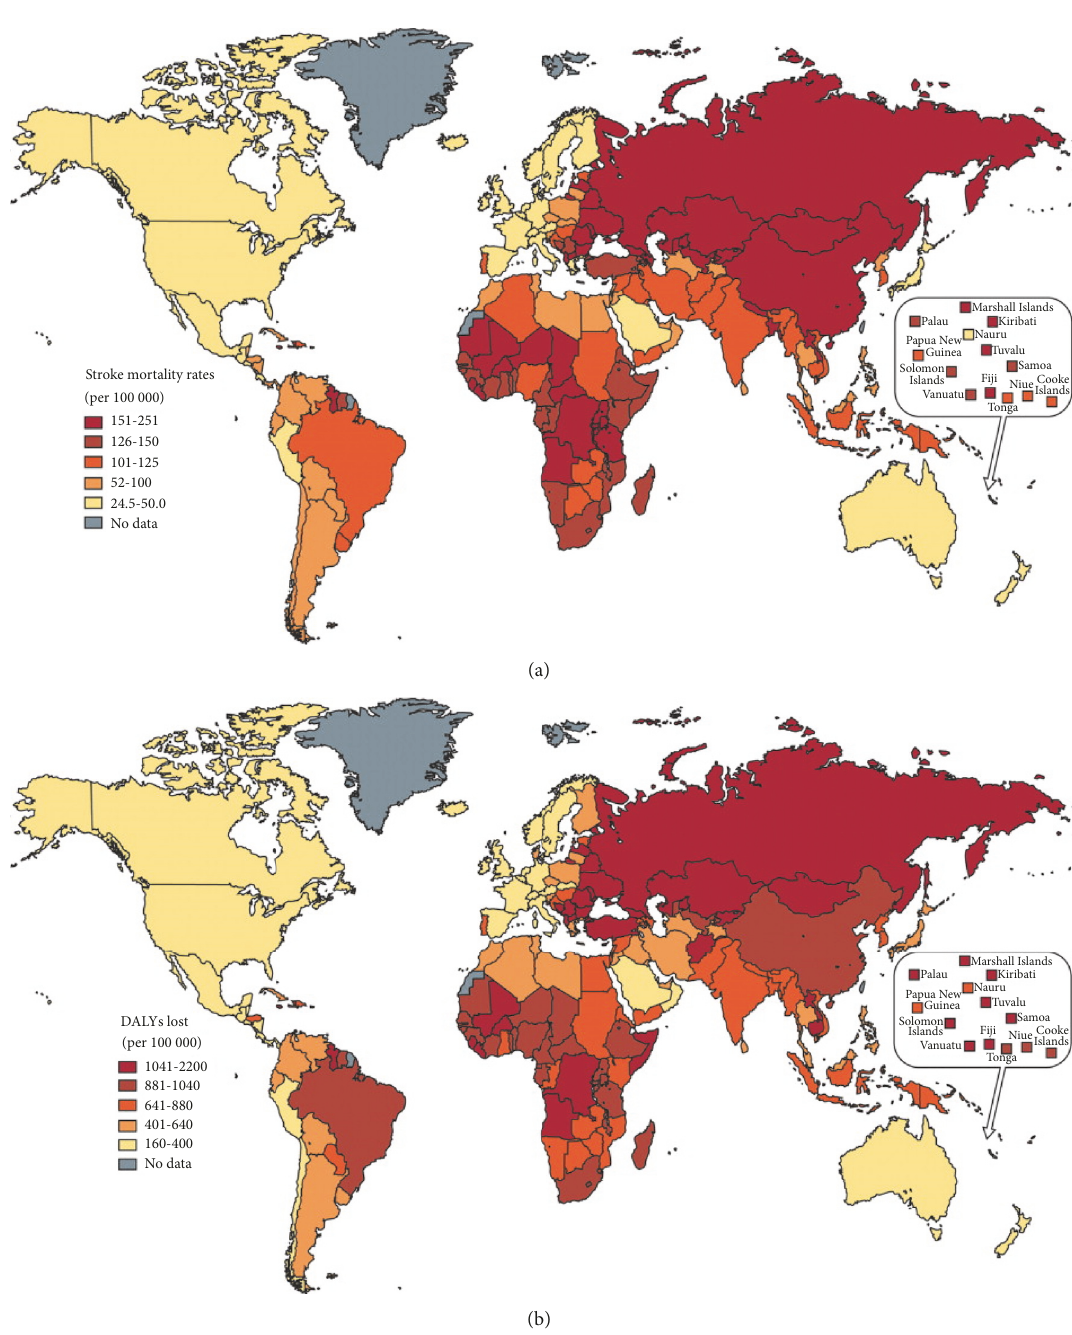
Figure 1: (a) Global distribution of stroke mortality rates. (b) Global distribution of DALY loss due to stroke (source of Figures 1(a) and 1(b): Johnston et al .